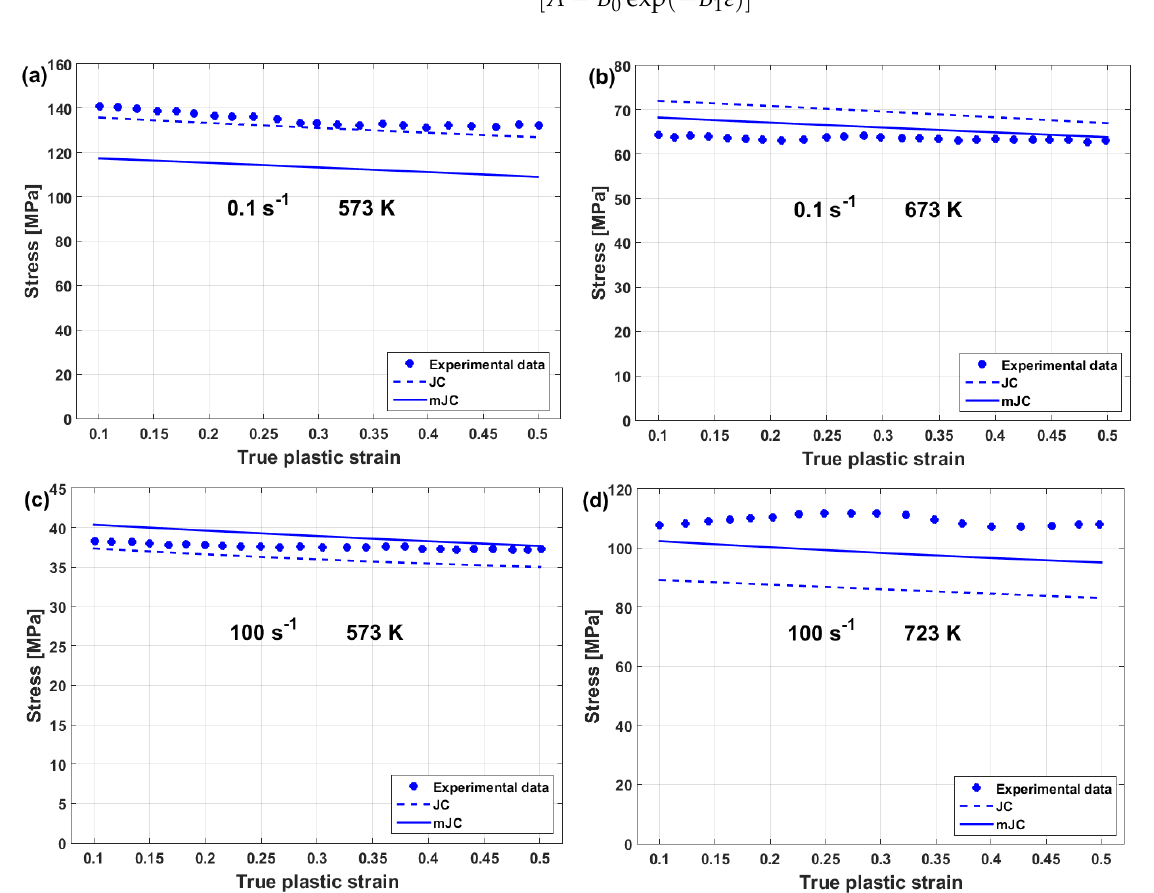
Figure 20. Comparison of experimental stresses and predicted stresses obtained by JC and the modified JC that was presented by Maheshwari et al. [76] for Al-2024 alloy at ( a ) 0.1 s −1 and 573 K, ( b ) 0.1 s −1 and 673 K, ( c ) 100 s −1 and 573 K, and ( d ) 100 s −1 and 723 K. By plotting σ / [ A − B 0 exp ( − B 1 ε )] vs. ln ( ε ·∗ ) at different strain and strain rate